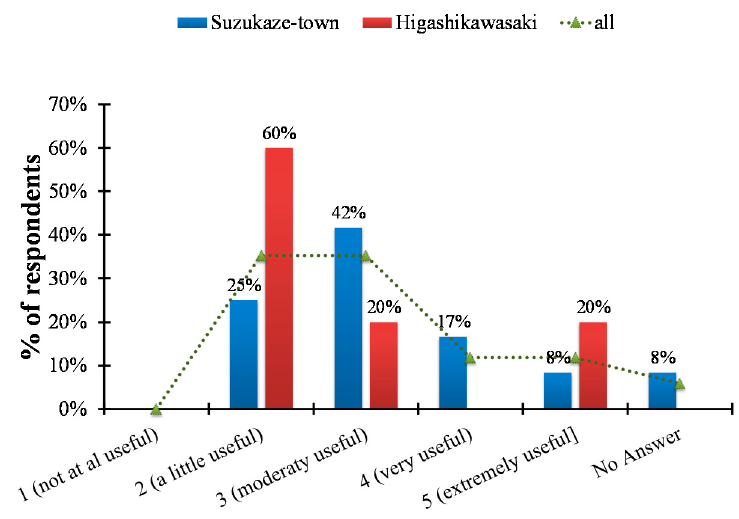
Figure 14. Distribution of respondent regarding whether the information they obtained on the storm surge was useful (n = 5 for Higashi-Kawasaki town, n = 12 for Suzukaze town).